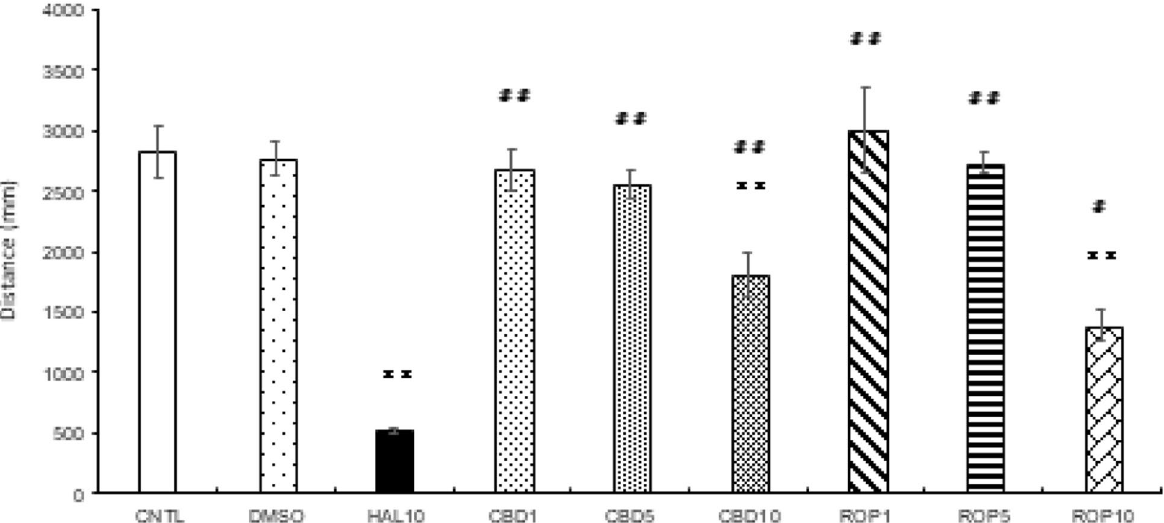
Fig. 3. Effect of HAL 10 mg/L CBD on light/dark-stimulation response. The distance traveled in the second light and sixth dark condition + decreased in the HAL 10 CBD 1 (mg/L) group compared with the CNTL ( a ). In the HAL10 + conditions did not show a significant difference compared with the CNTL ( b ). In the HAL 10 mg/L traveled in the first light condition increased, all dark conditions showed a significant decrease compared with the CNTL ( c ). In the HAL 10 mg/L CBD 1 mg/L group, the response from the second to the fifth dark condition was significantly improved compared to the HAL 10 mg/L group + ( d ). In the HAL 10 mg/L CBD 5 mg/L group, the response was significantly enhanced in the fifth dark condition as compared with HAL 10 mg/L; + however, the response was significantly improved in all dark conditions ( e ). In the HAL 10 mg/L only in the first and the third light conditions as compared with the HAL 10 mg/L group ( f ). CNTL: Control, HAL10: Haloperidol 10 mg/L, CBD 1, 5, 10: Cannabidiol 1, 5, 10 mg/L, ON: light-on period, OFF: light-off period. Tukey–Kramer test; * p <0.05, ** p <0.01. All values are presented as means SEMs (